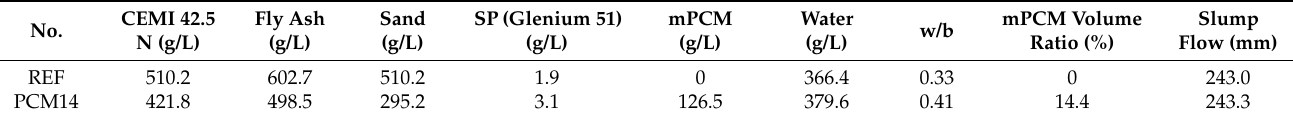
Table 1. Mixture proportions and corresponding slump flow